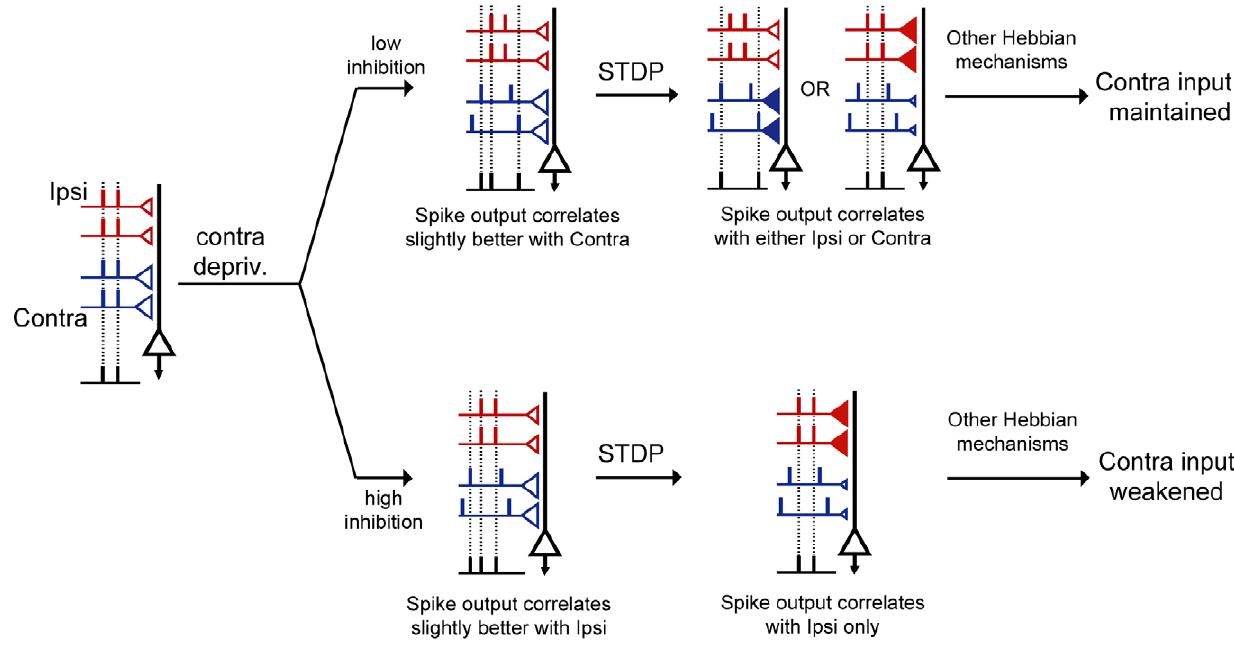
Figure 9. Proposed mechanism by which maturation of inhibition promotes OD shift of class 2/3 neurons in V1. Symbol designs are the same as in Figure 2. In addition, the filled red and blue triangles highlight the increase of synaptic weights. From left to right, a class 2/3 binocular neuron is driven by convergent ipsi- (red) and contralateral (blue) input pathways. The contralateral bias is indicated by the larger triangles in the blue pathway. Contralateral deprivation decreases the temporal coherence among inputs of the contralateral pathway. The effect of this altered temporal structure on the correlation between pre- and postsynaptic spike times is dependent on the level of inhibition. When inhibition is immature (low inhibition, upper row), spike output of the class 2/3 neuron correlates slightly better with the contralateral input compared to the ipsilateral input. Through STDP, either the ipsi or the contralateral pathway can increase its correlation with the postsynaptic outputs at the expense of a decreased correlation of the other pathway (STDP-mediated increases in synaptic weight are indicated by filled triangles and decreases indicated by smaller open triangles). Since P1 inputs fail to drive postsynaptic spiking, Hebbian mechanisms will not be able to weaken the contralateral deprived eye inputs and strengthen the ipsilateral open eye input. A shift in OD fails to occur. When inhibition is mature (lower row), the spike output of the class 2/3 neuron correlates slightly better with the more coherent ipsilateral, open eye input. In the presence of STDP, open-eye inputs will be able to control postsynaptic spike timing, thus, association-based Hebbian mechanisms can